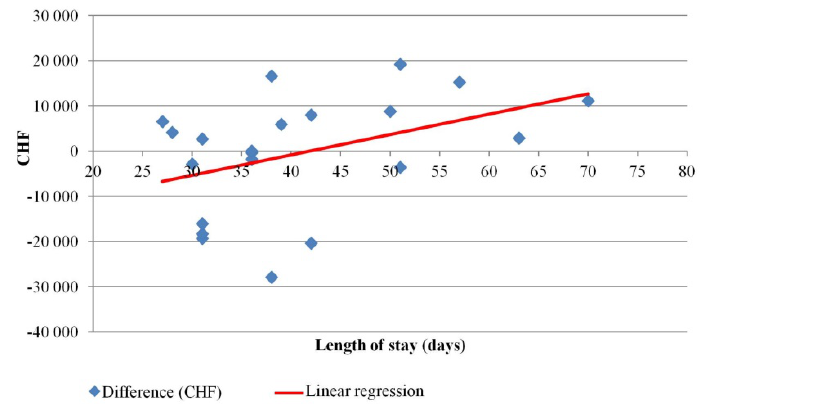
Figure 9. Difference between costs and double